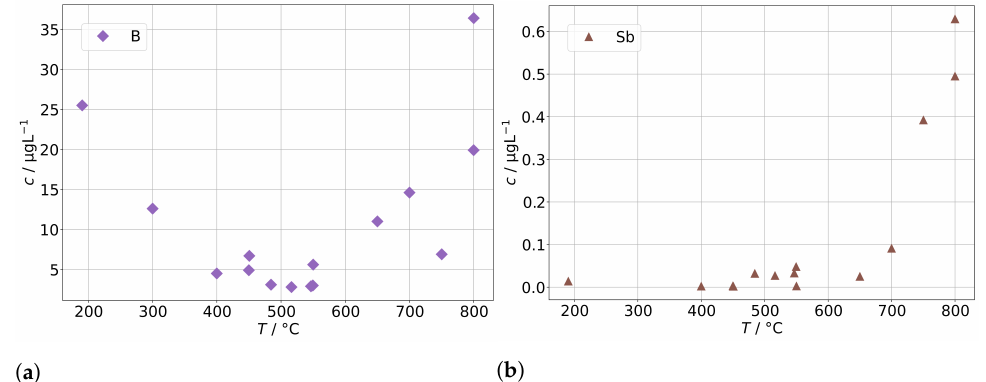
Figure 13. Concentrations of ( a ) boron and ( b ) antimony in steam condensates obtained after the fuel gas preheater in dependence of the preheater operation